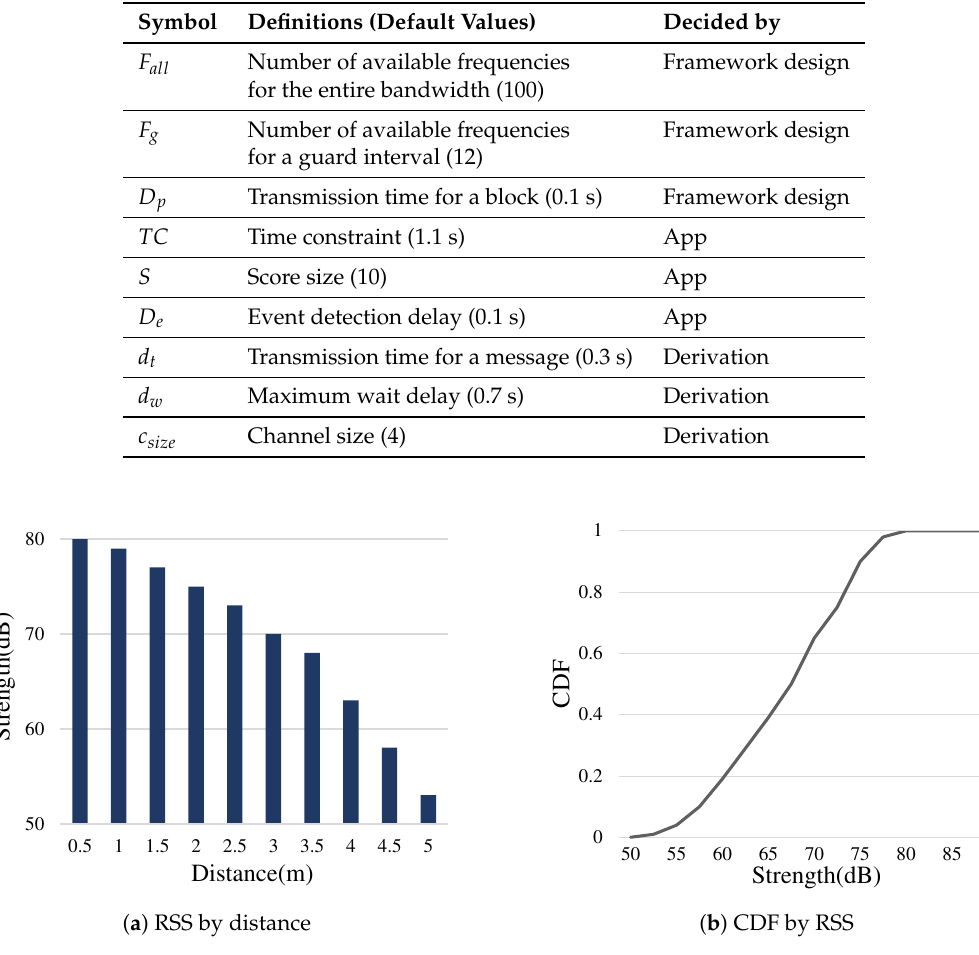
Figure 7. Voice Event Strength: ( a ) the average RSS of smartphones detecting user hotwords with respect to the distance from the user, 0.5 to 5 m; and ( b ) its cumulative distribution. Each measurement was performed 100 times for 10 different distances and two